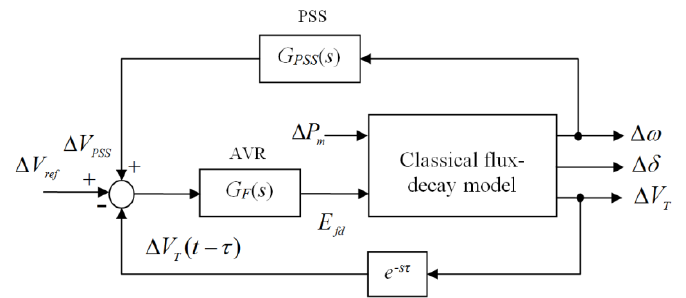
Figure 2. A single-machine-infinite-bus power system with an exciter.